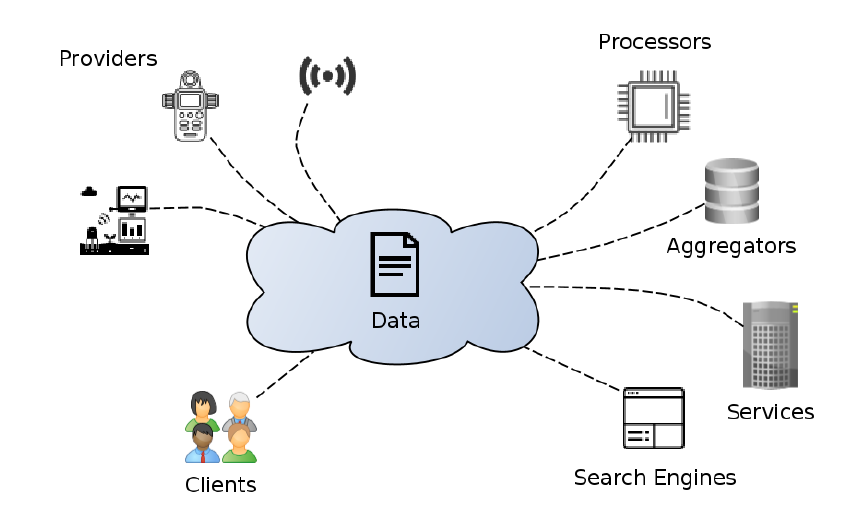
Figure 1. General view of different parties involved in data